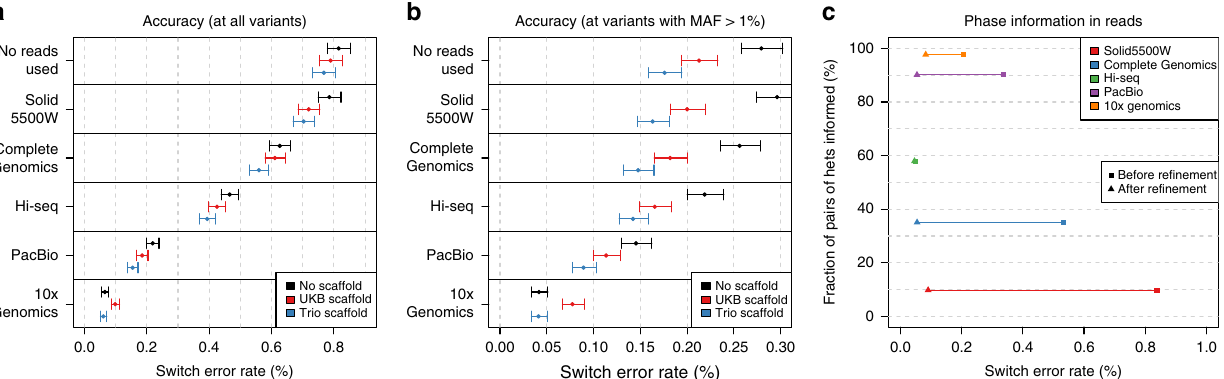
Fig. 4 Phasing performance on high-coverage sequence data (GIAB). a Switch error rates with 95% binomial con fi dence intervals for each combination tested of sequencing reads and haplotype scaffold. b Same information than in a measured only at variants with minor allele frequency (MAF) above 1%. c Switch error rates measured only at variants belonging to phase sets (i.e., haplotype assembly) before (squares) and after (triangles) re fi nement by SHAPEIT4. Results are shown here assuming 0.01% error rate in the phase sets. Source data are provided as a Source Data fi